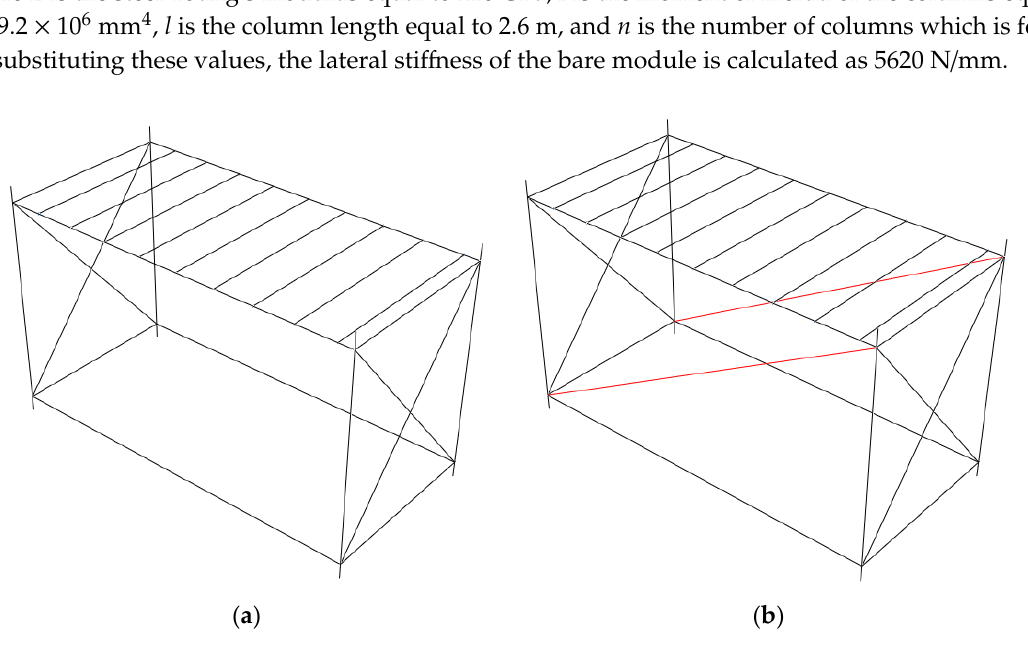
Figure 15. Numerical macro-model of ( a ) bare module, ( b ) module with added equivalent struts.